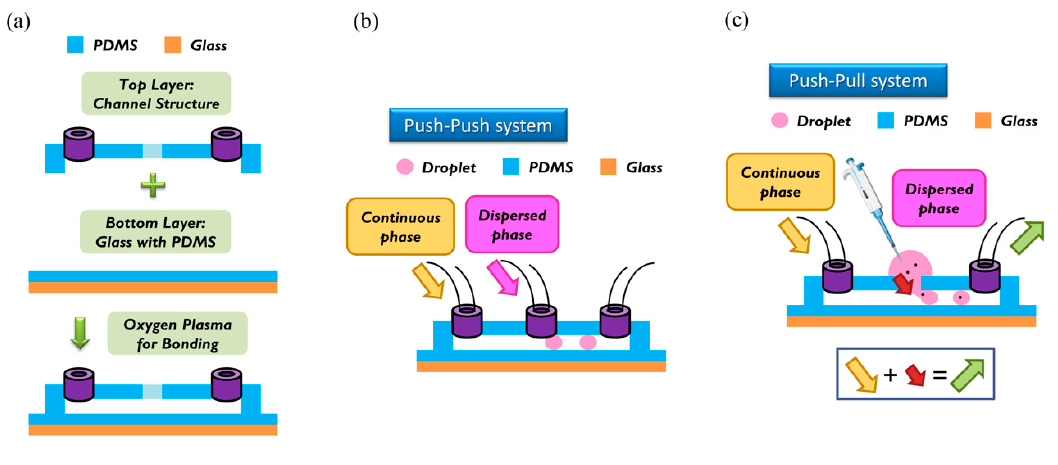
Figure 2. ( a ) Top layer (channel structure) and bottom layer (glass with polydimethylsiloxane (PDMS)) were bonded together with an oxygen plasma. ( b ) In the push-push system,